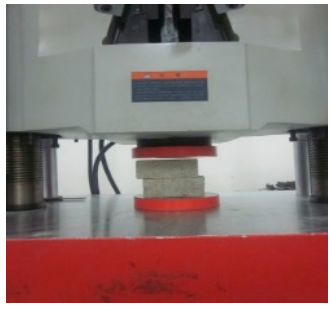
Figure 5. Compression test of brick.